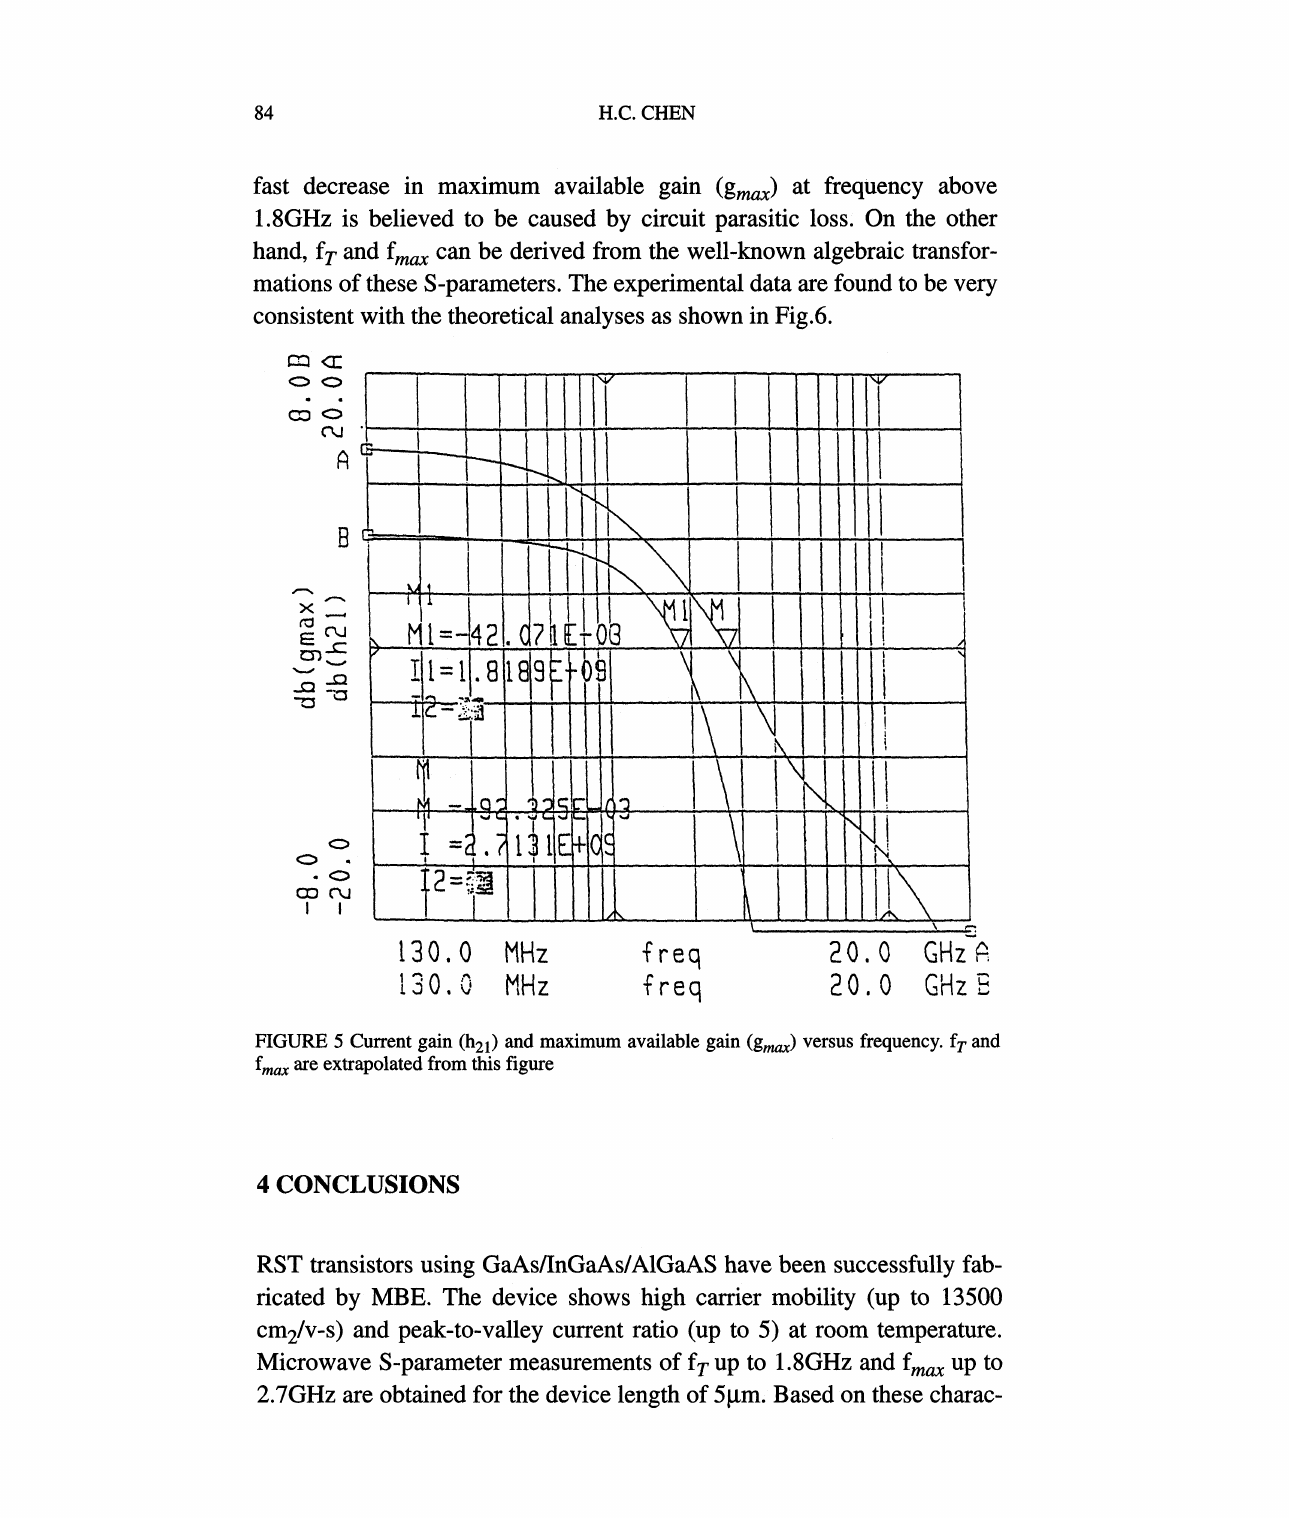
FIGURE 5 Current gain (h21) and maximum available gain (gmax) versus frequency, fT and fmax are extrapolated from this